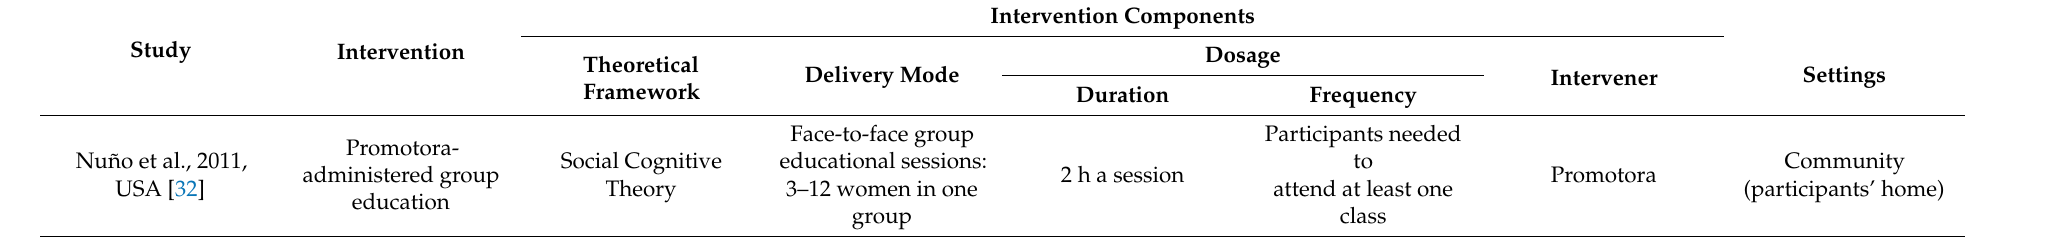
Table 4. Intervention